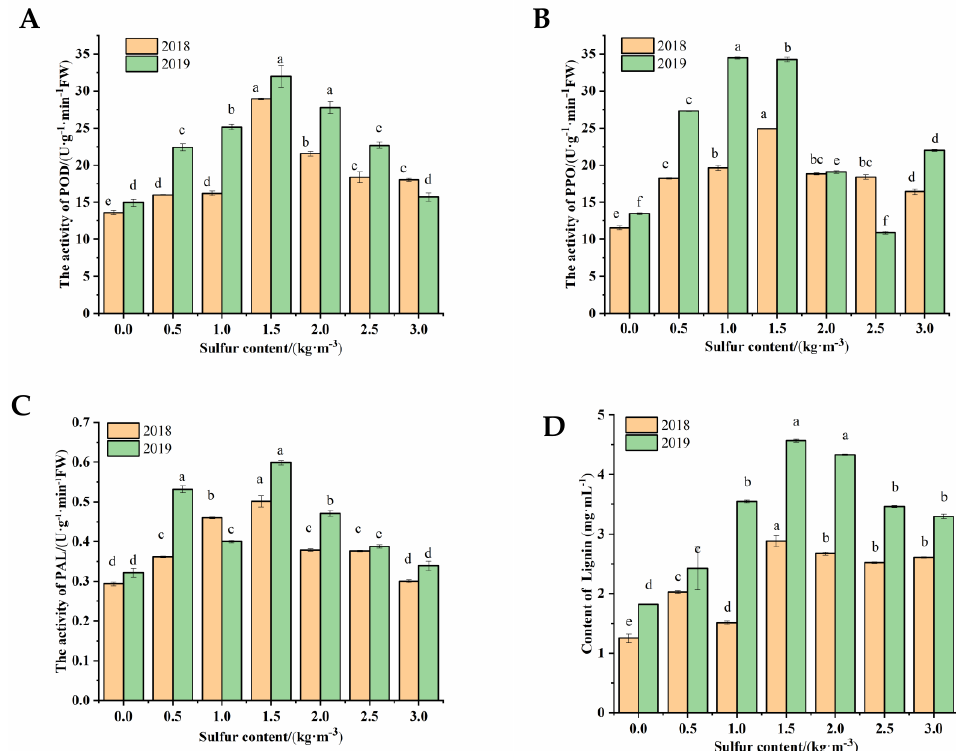
Figure 4. Effect of sulfur treatment on phenolic components of kiwifruit stems. ( A ) (POD activity), ( B ) (PPO activity), ( C ) (PAL activity) and ( D ) (lignin content) of Psa_infected kiwifruit stems. Different lowercase letters indicate significant differences between different treatments ( p < 0.05).